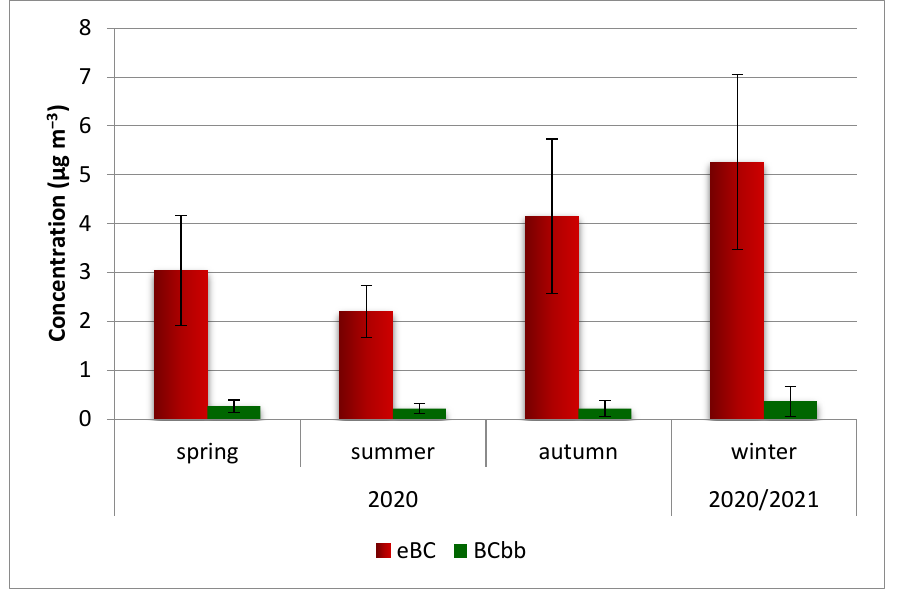
Figure 6. Seasonal concentrations of eBC and BC bb in µg m −3 .